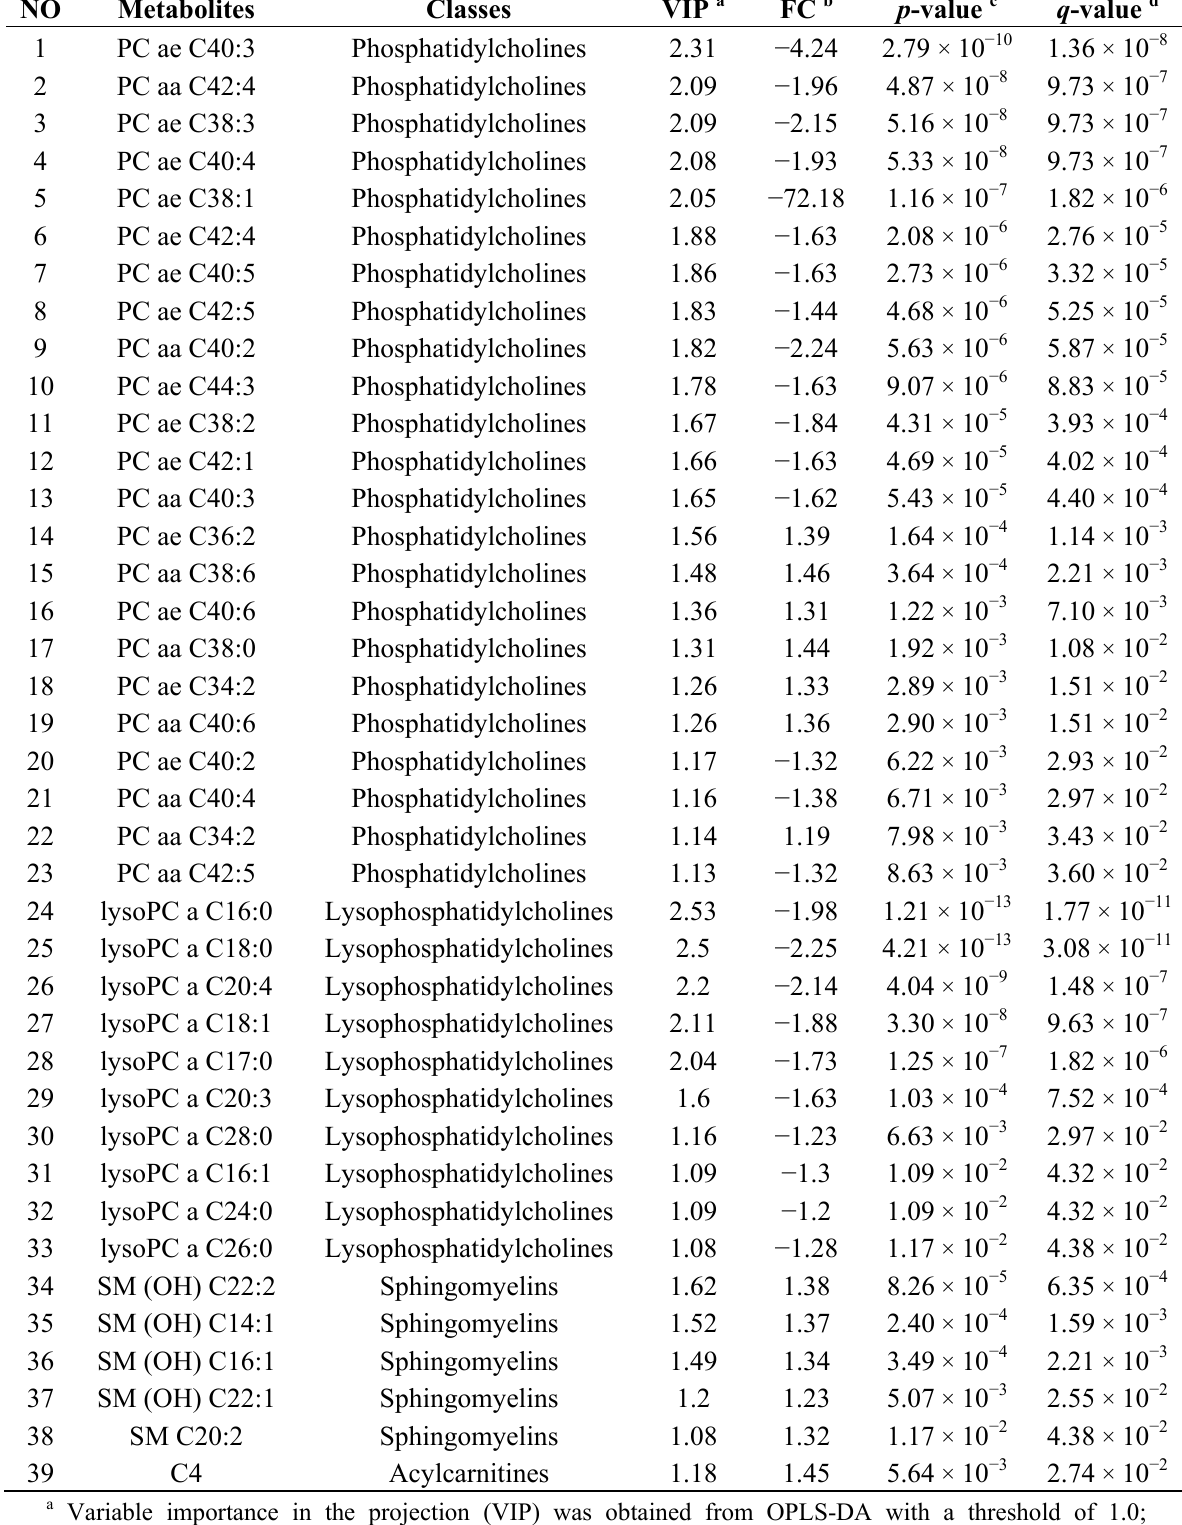
Table 1. Differentiating metabolites between breast cancer patients and healthy controls identified from the learning